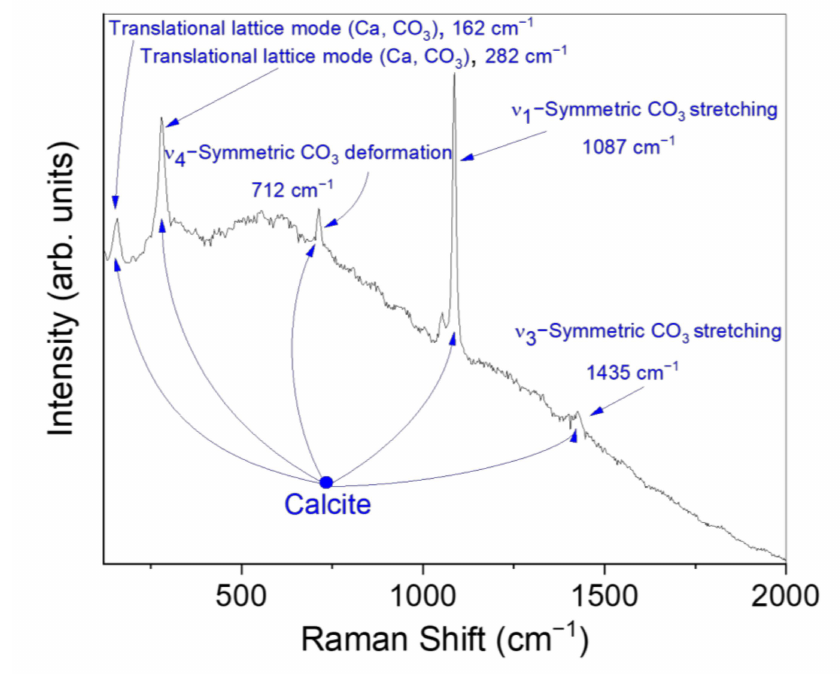
Figure 2. Raman spectrum recorded on the preparatory